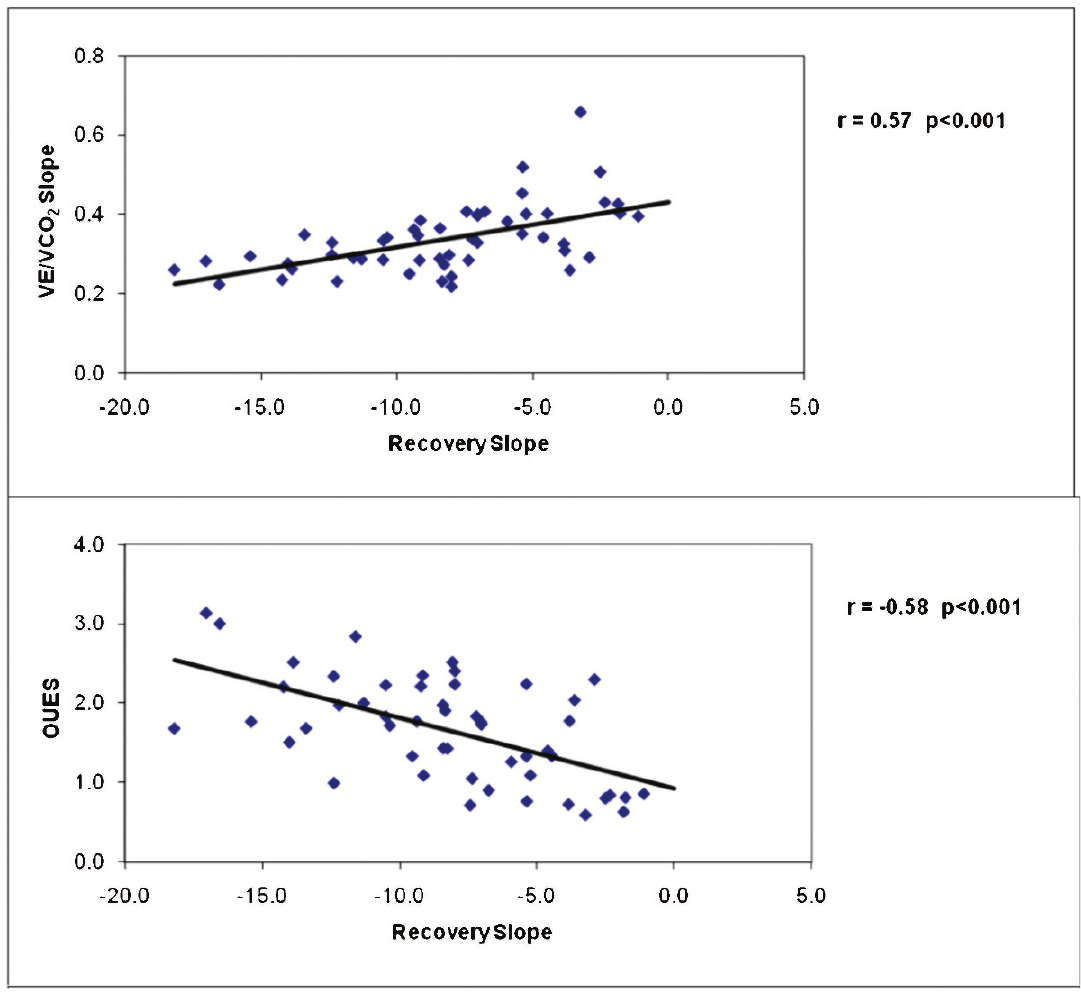
Figure 2 - The relationships between the VE/VCO 2 slope, oxygen uptake efficiency slope (OUES), and cardiac output slope